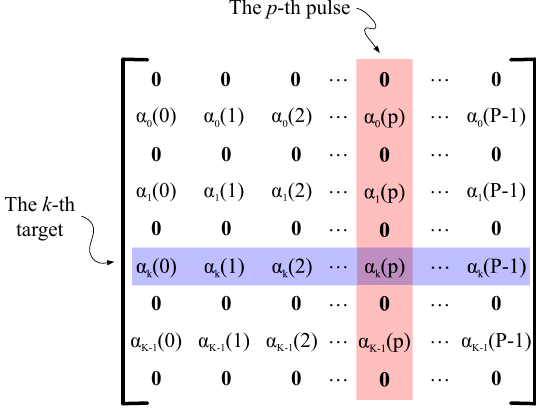
Figure 2. The structure of sparse matrix X